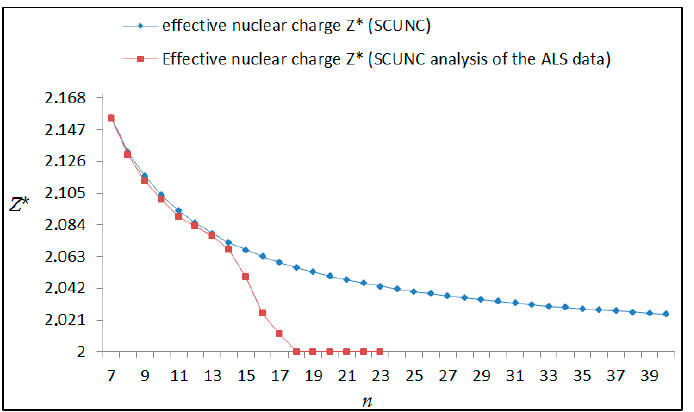
Figure 20. Variations of the effective nuclear charge Z* with the principal quantum number n for the 4 s 2 4 p 2 ( 1 D 2 ) ns ( 2 D ) Rydberg series originating from 2 D ° 5/2 metastable state of Se + converging to the 1 D 2 series limits in Se 2+ . ** Energy differences relative to the ALS experimental data. Table 11. Energy resonances ( E ), quantum defect ( δ ) and effective charge ( Z *) of the 4 s 2 4 p 2 ( 1 D 2 ) ns ( 2 D ) Rydberg series originating from the 4 s 2 4 p 3 2 D° 3/2 metastable state of Se + converging to the 1 D 2 series limit in Se 2+ . The present results (SCUNC) are compared with the experimental data from ALS measurements